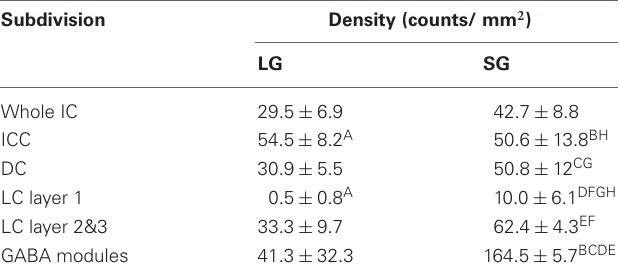
Table 2 | Density of two classes of GABAergic neuron in IC subdivisions.